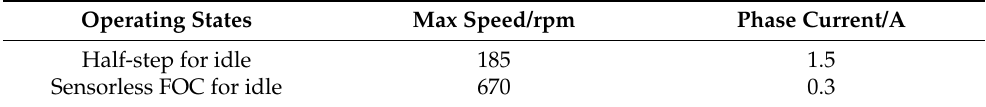
Table 5. The maximum speed in idle operation.